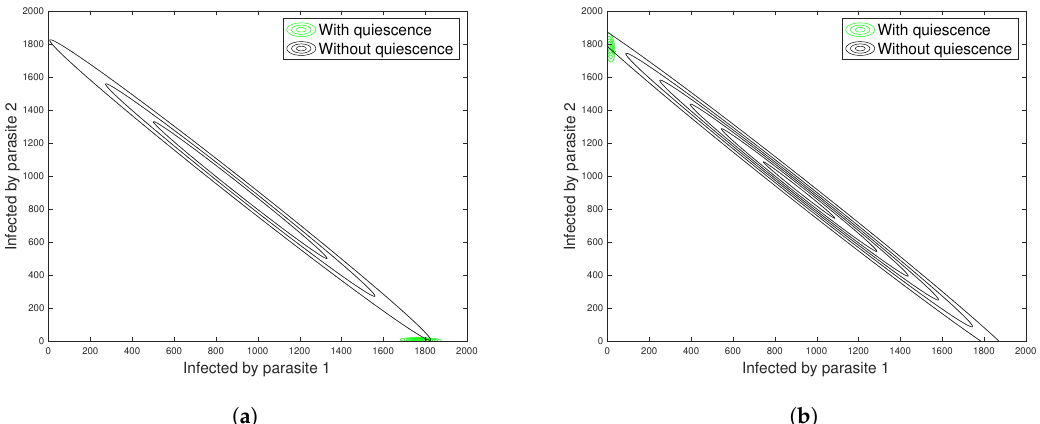
Figure 3. Contour plots of the joint density of infected individuals by strain 1 and 2 based on simulations for ( a ) Example 4, and ( b ) Example 5 considered in the text. The x -axis is the number of infected individuals of strain 1 while the y -axis is the number of infected individuals by strain 2 based on the parameters stated in each